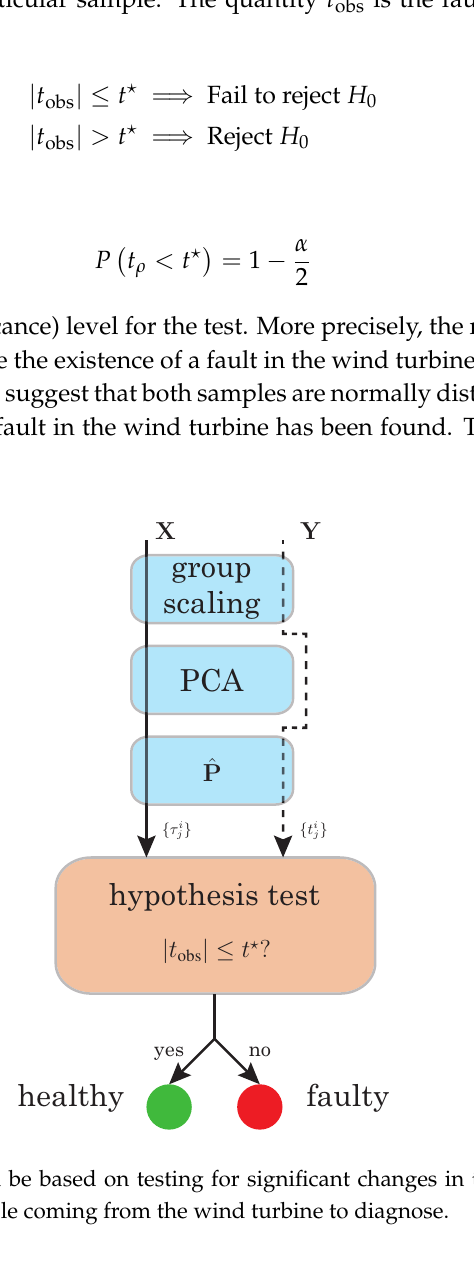
2 WindEnerg. 2010; 00 :1–1 c (cid:13) 2010JohnWiley&Sons,Ltd.